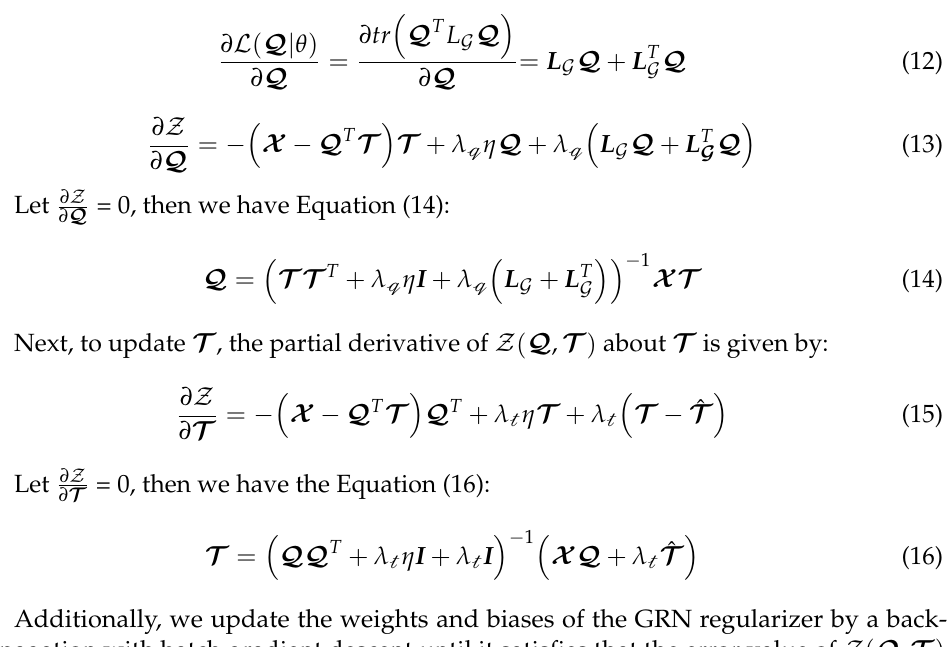
Figure 1. Illustration of multivariate time series forecasting (each 𝔁 (cid:3047) is a frame of traffic data at time step 𝑡